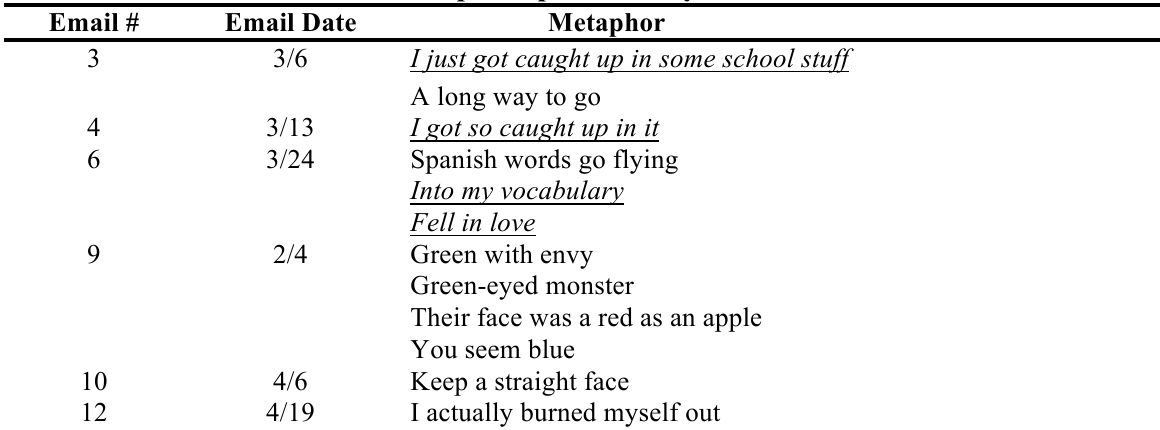
Metaphors produced by